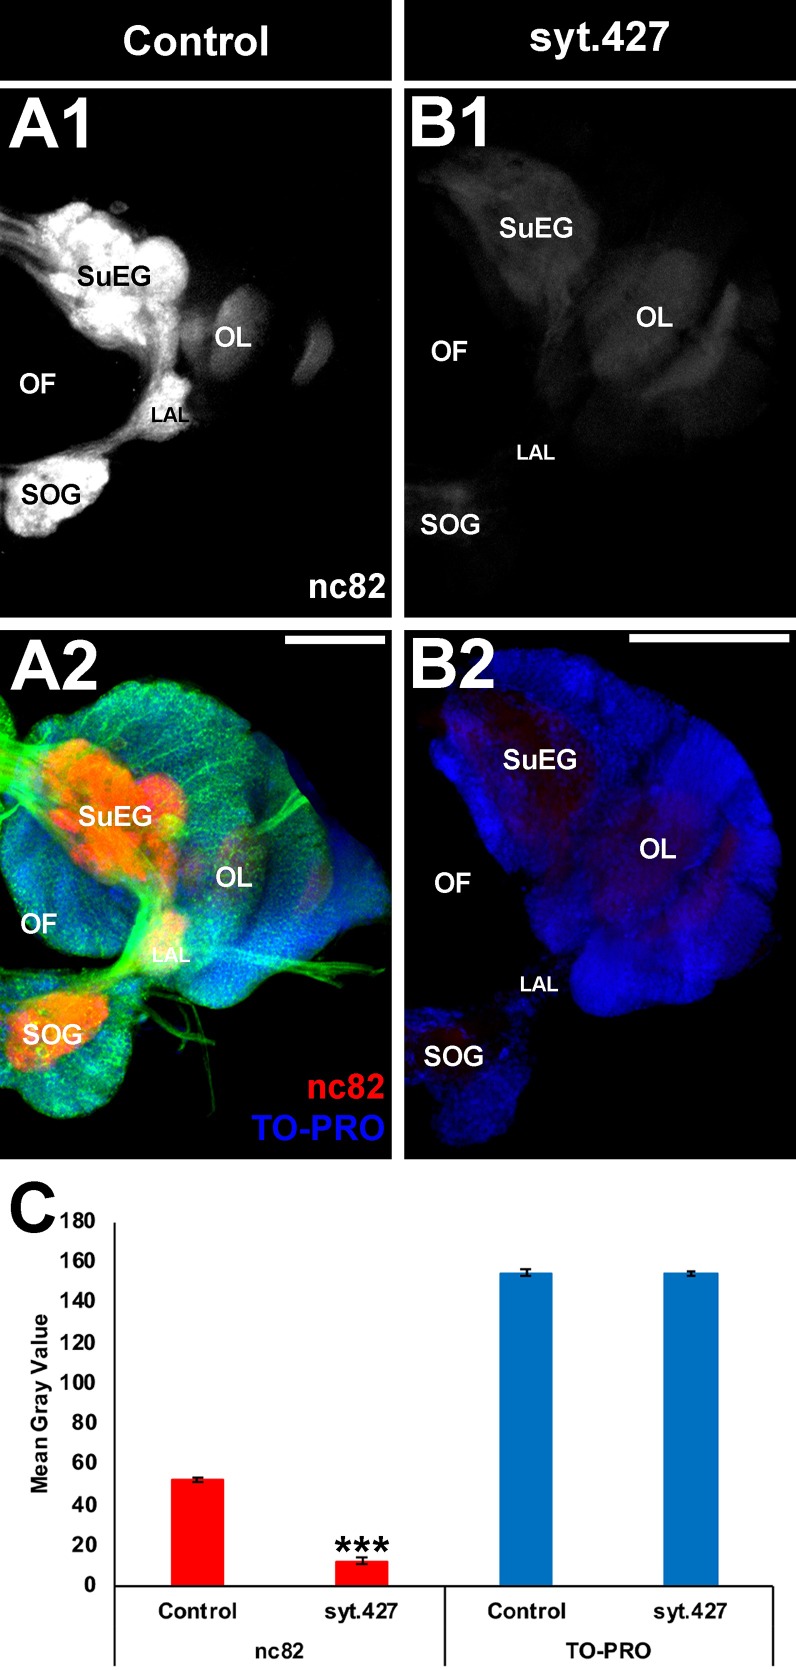
Neural defects observed in the L4 brains of larvae fed with yeast interfering RNA larvicide syt.427.Stage L4 larval brains were labeled with mAbnc82 (white in A1, B1; red in A2, B2), which labels synaptic active zones. nc82 levels were significantly reduced (C) in the synaptic neuropil of L4 larvae that had consumed syt.427 (B1, B2; compare to white staining of control brain in A1/red staining in A2), but levels of TO-PRO, which marks nuclei, were not significantly different (C) between syt.427- (B2) and control-treated (A2) larvae. Data compiled from three biological replicate experiments containing a total of 80 syt.427-treated and 49 control-treated larvae are shown and were evaluated with a paired t-test (C). Data are represented as average mean grey values, and error bars denote SEM (C). *** = P<0.001 when compared with control-fed larvae. Representative brains from these experiments are oriented dorsal upward in this figure. LAL: larval antennal lobe; OF: olfactory foramen; OL: optic lobe; SOG: sub-esophageal ganglion; SuEG: supra-esophageal ganglion. Scale Bar = 100 μm.